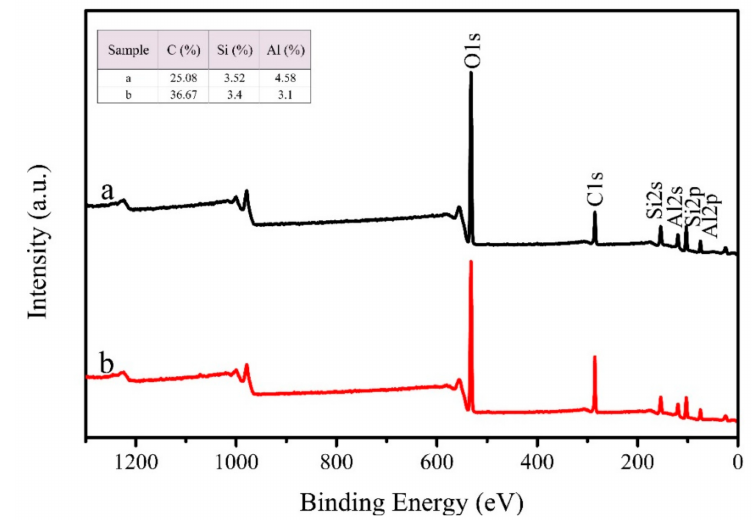
Figure 2. X-ray photoelectron spectroscopy (XPS) spectra of ( a ) unmodified kaolin (KL); ( b ) stearic acid (STA) modified KL.